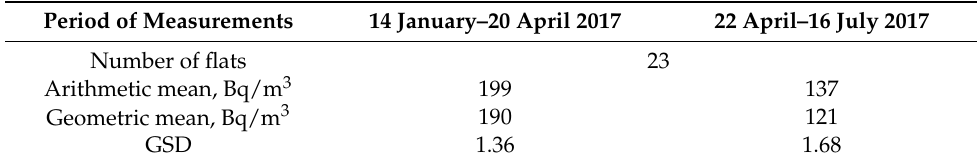
Figure 1. Ranges of the outdoor temperatures during the radon series measurements in flats by ID. Table 3. Results of radon survey in multistorey building in